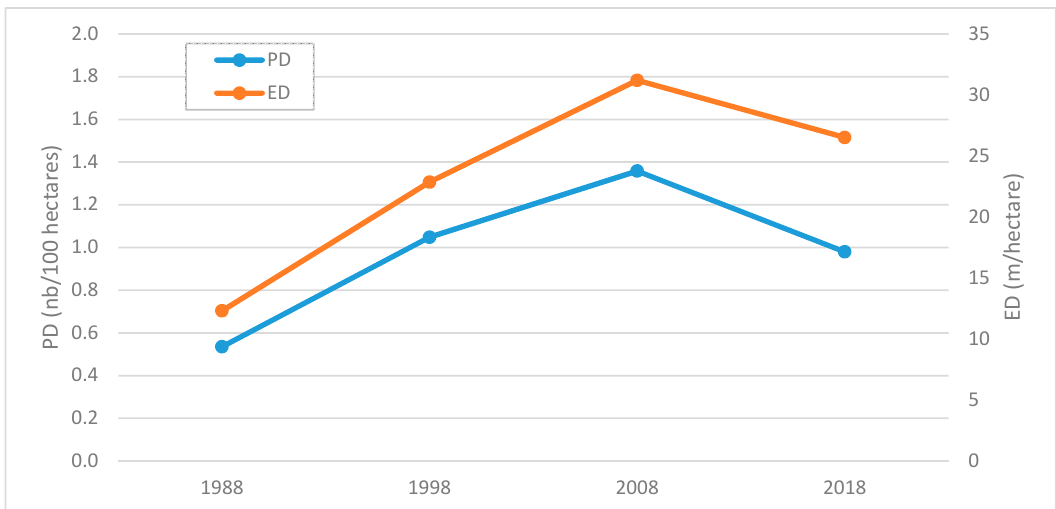
Figure 10. Evolution of the fragmentation indices, Patch Density (PD, number per 100 hectares) and Edge Density (ED, metres per hectares), as a function of time, from 1988 to 2018.